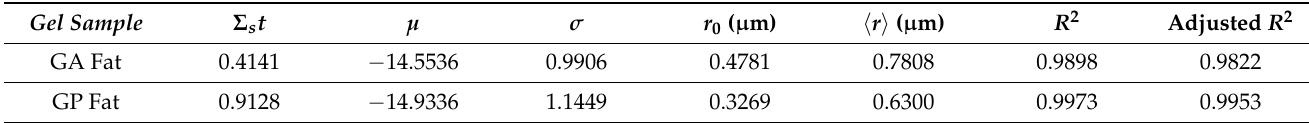
Table 5. The structural parameters and goodness of fits for fat globules (FG) in the fat milk